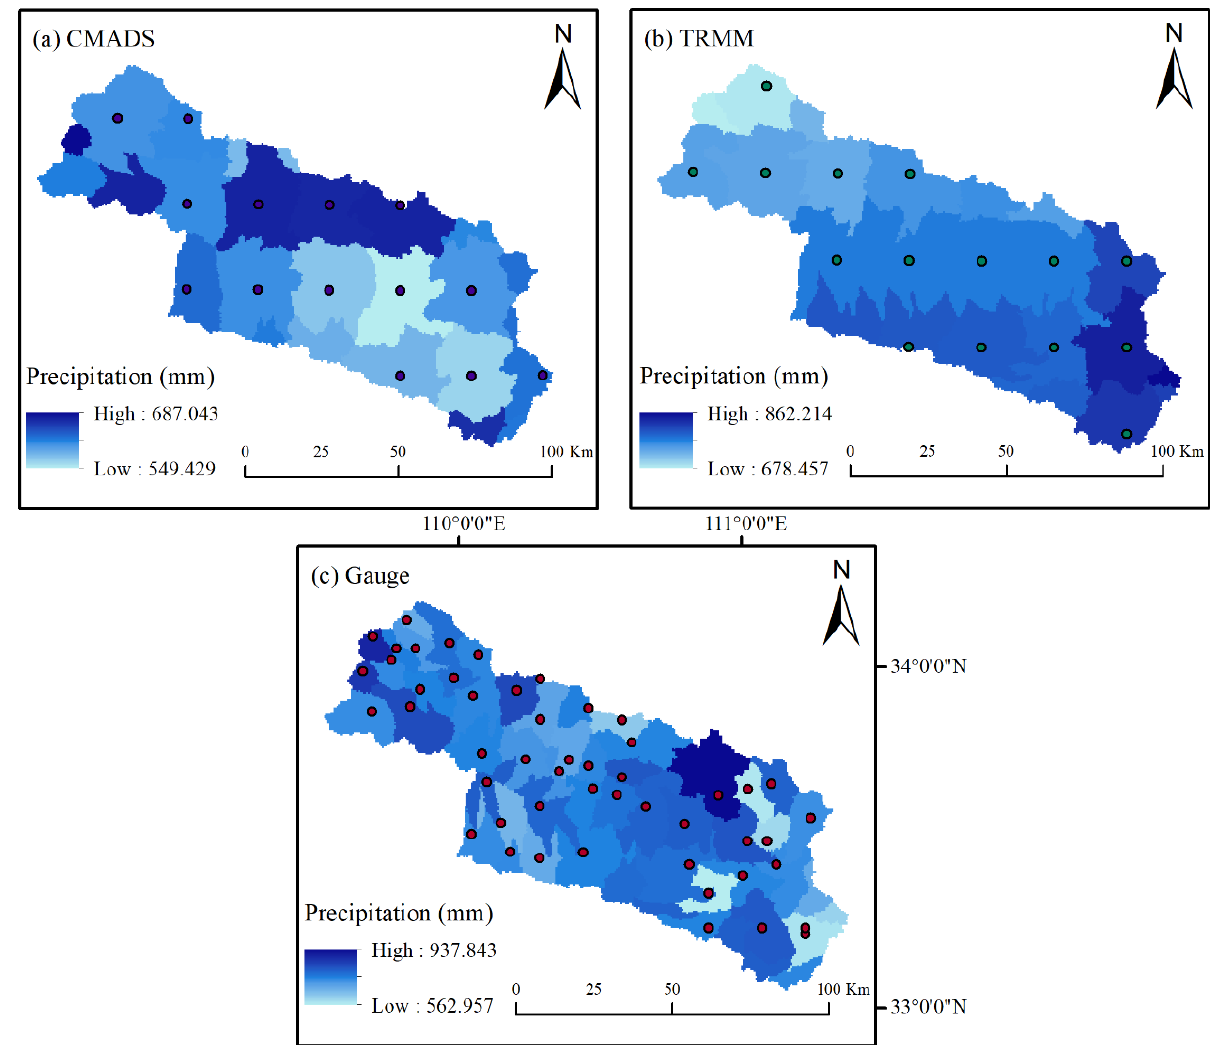
Figure 6. Spatial variation of precipitation at a yearly scale for all sub-basins calculated with precipitation inputs from ( a ) CMADS, ( b ) TRMM, and ( c ) Gauge.